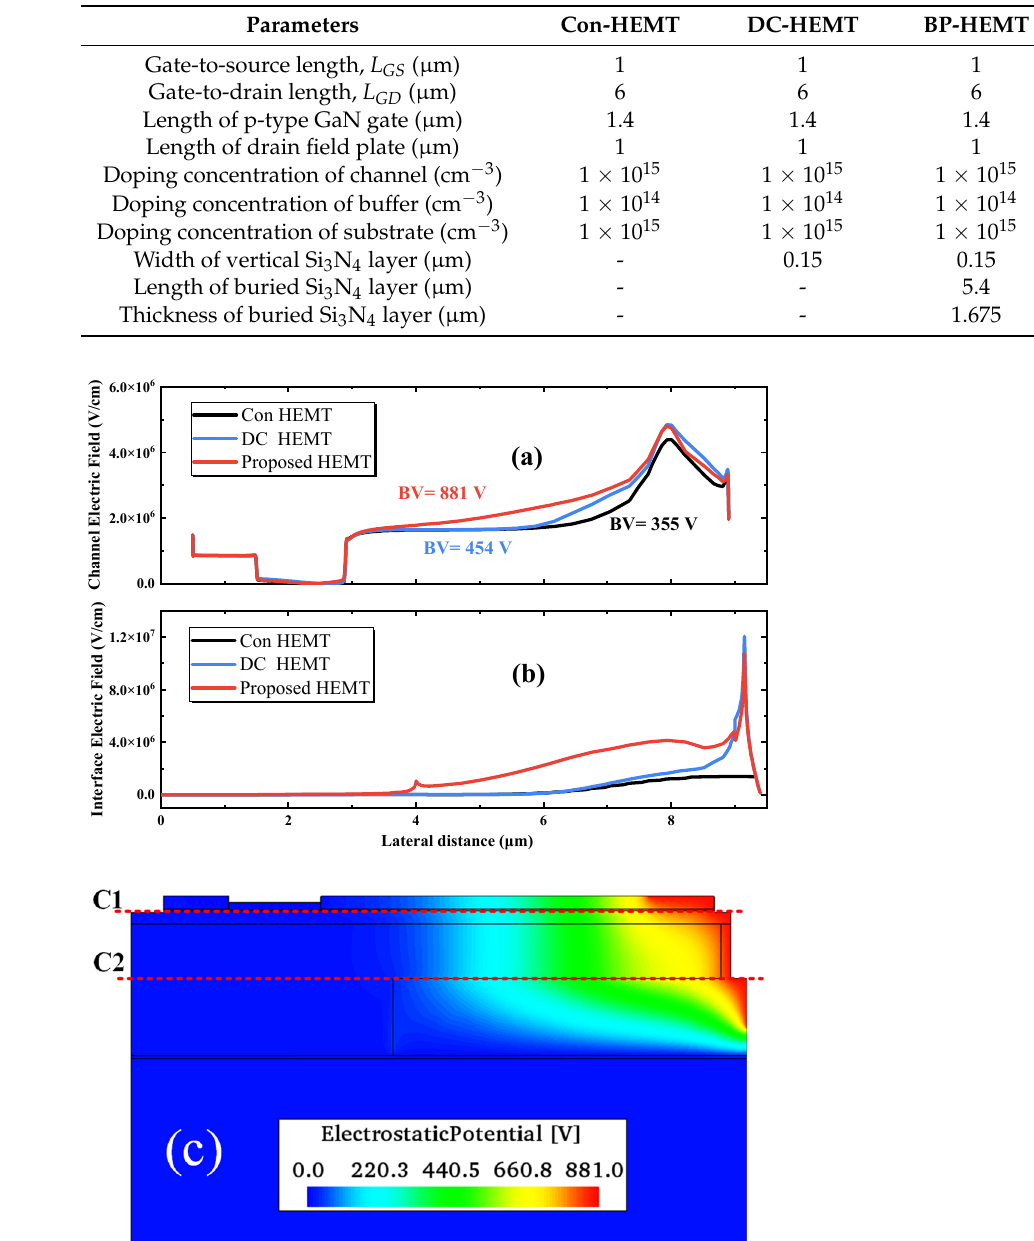
( b ) Figure 4. The 2-D electric field distribution in the whole buffer region of ( a ) BP-HEMT and ( b ) DC- HEMT.